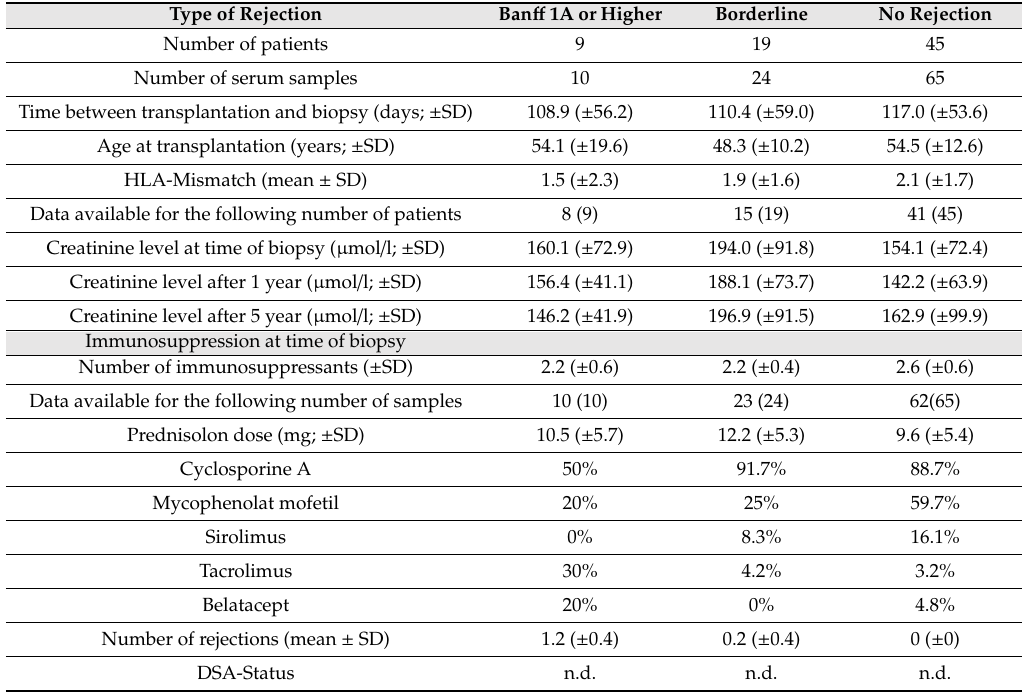
Table 1. Patient characteristics (study